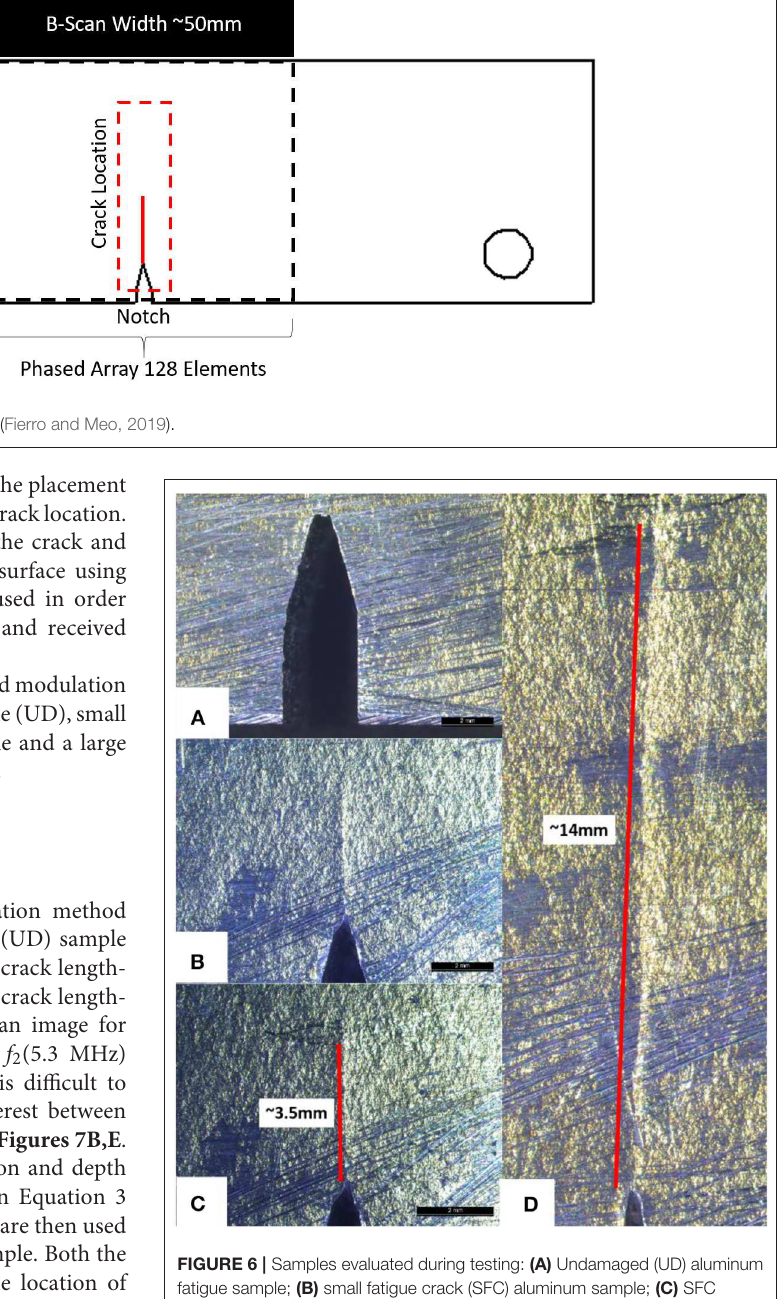
FIGURE 6 | Samples evaluated during testing: (A) Undamaged (UD) aluminum fatigue sample; (B) small fatigue crack (SFC) aluminum sample; (C) SFC showing crack length; (D) large fatigue crack aluminum